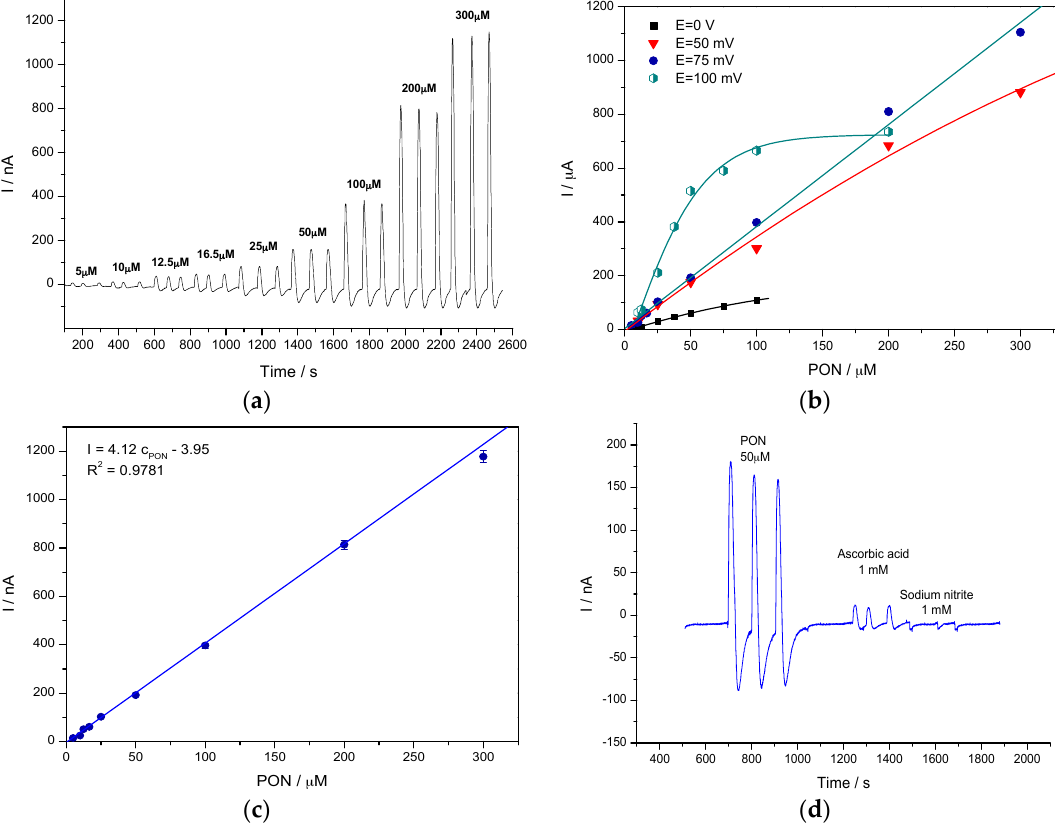
Figure 9. ( a ) FIA amperogram for different PON concentration solutions. E = +75 mV; flow rate = 0.38 mL · min − 1 ; ( b ) Dependence of FIA height on the applied potential for different concentration of PON; flow rate = 0.38 mL · min − 1 ; ( c ) Calibration graph for PON determination by FIA amperometry in optimized conditions; E = +75 mV; flow rate = 0.38 mL · min − 1 ; ( d ) FIA signals for PON 50 µ M, ascorbic acid 1 mM and sodium nitrite 0.1 M; E = +75 mV; flow rate = 0.38 mL · min − 1 .